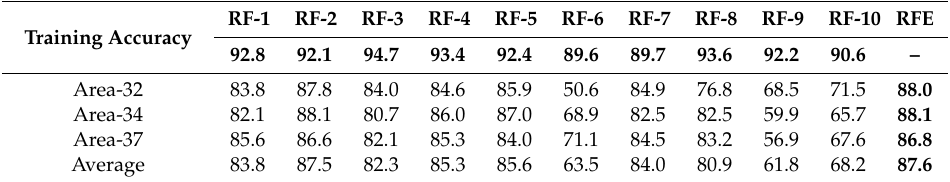
Table 2. Overall accuracies of 10 single RF classifiers (their training accuracies are shown in the second row) and the RF ensemble (RFE) tested on the testing set (area: 32, 34 and 37). The highest accuracy values for each area are shown in bold.